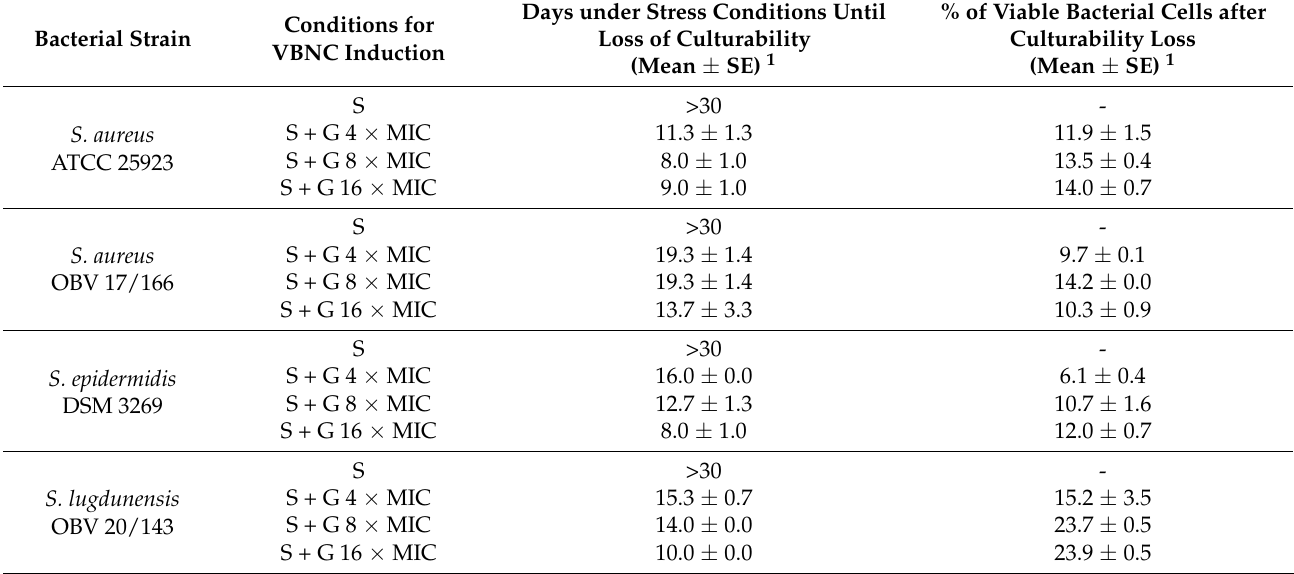
Table 1. Results of VBNC state induction in four staphylococcal strains.